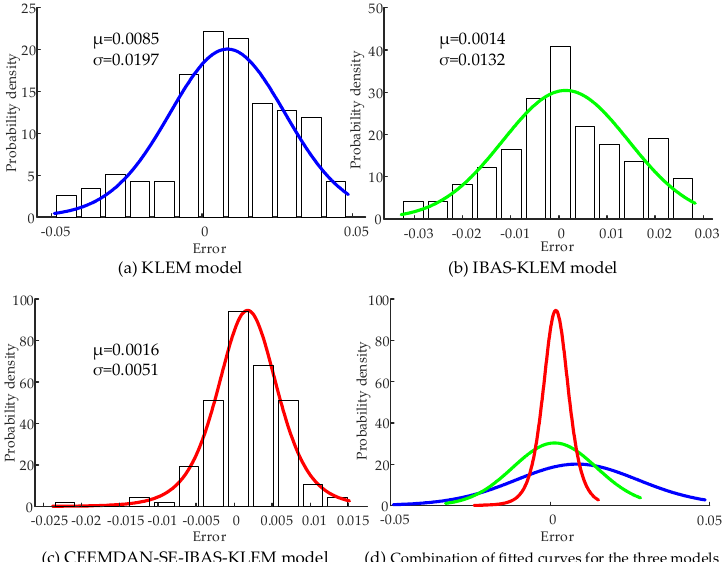
Figure 8. Frequency density histogram and fitting curve of each prediction model error.